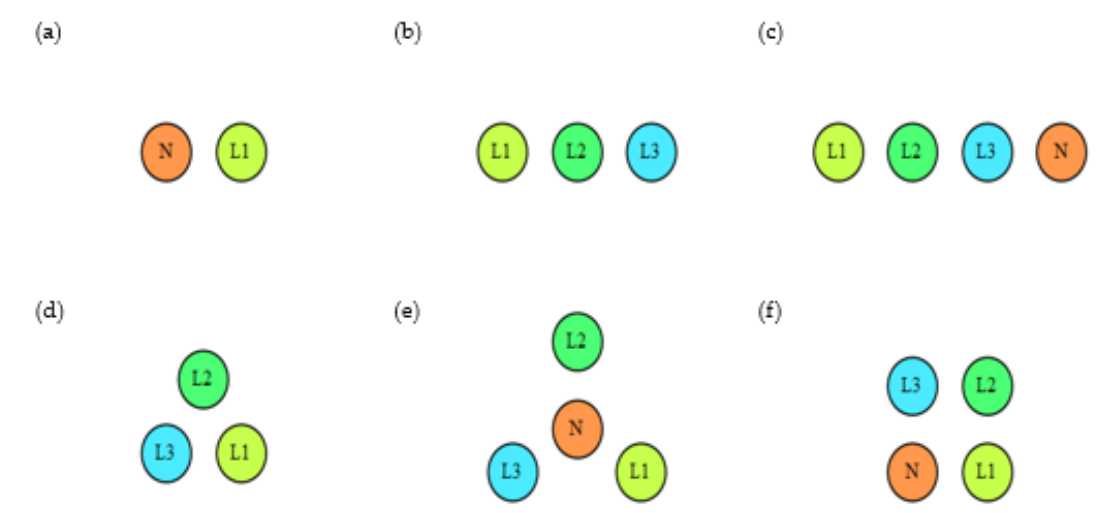
Figure 6. Analyzed current lines: ( a )—twin single-phase line; ( b )—flat three-phase line without N wire; ( c )—flat three-phase line with N wire; ( d )—trefoil three-phase line without N wire; ( e )—trefoil three-phase line with N wire; ( f )—three-phase line with N wire arranged in a square.